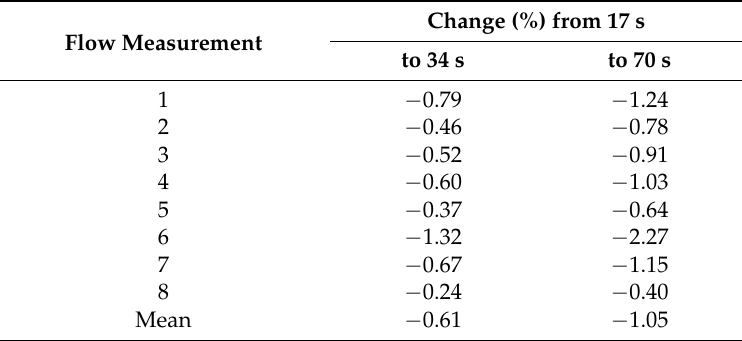
Table 2. Percent difference of uncertainty bandwidth for different times. Change (%) from 17 Flow Measurement